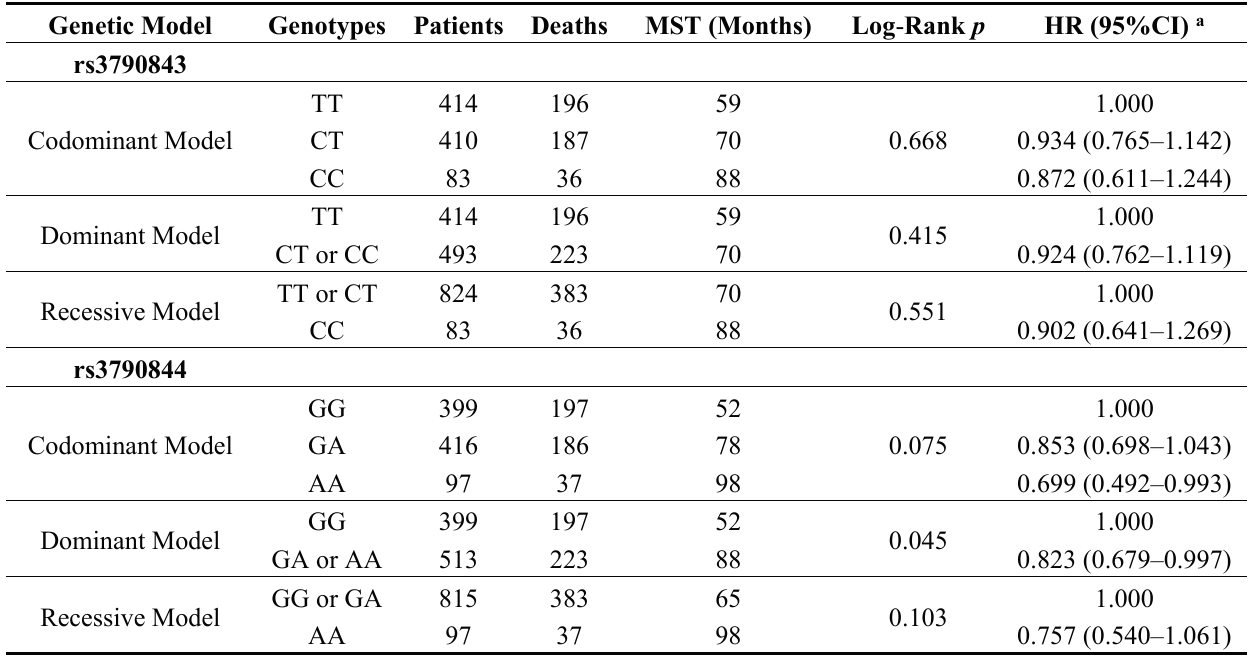
Table 4. Associations of NR5A2 rs3790843 and rs3790844 with clinical outcomes of overall